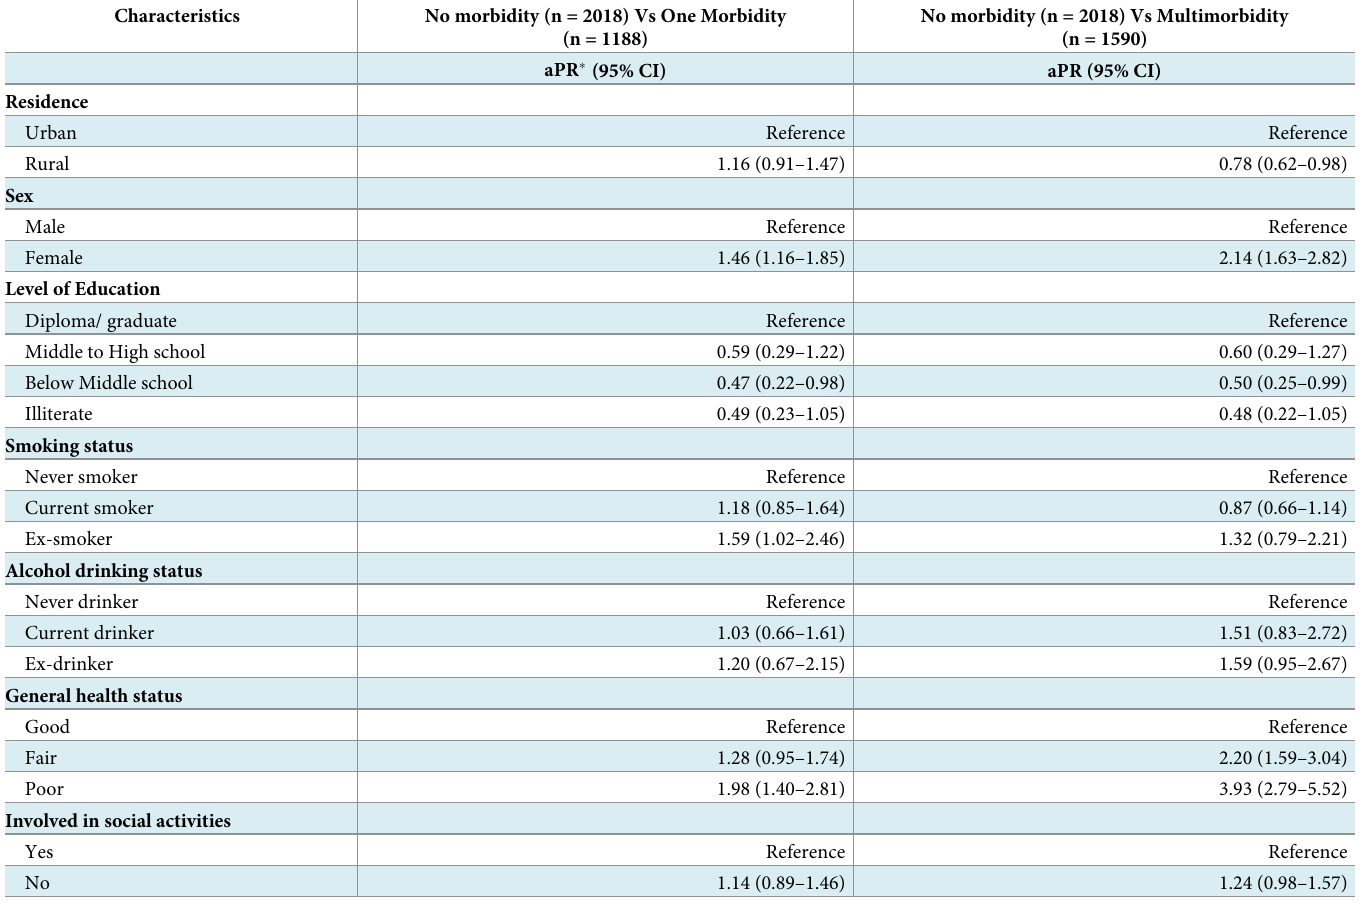
� aPR = Adjusted Prevalence Ratio. PRs are adjusted for all other variables in the